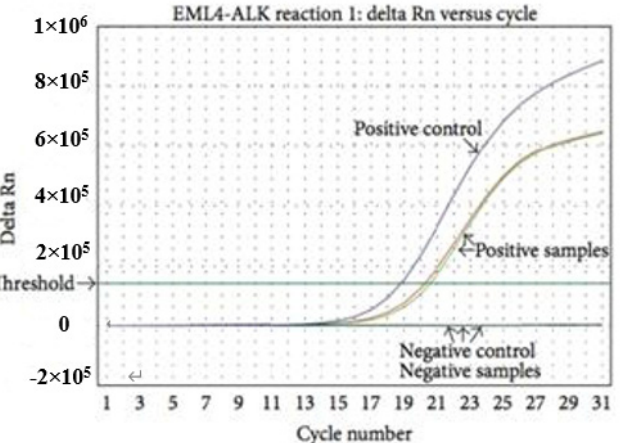
Figure 4. Realtime RT ‐ PCR; From AmoyDx EML4 ‐ ALK Fusion Gene Detection Kit.